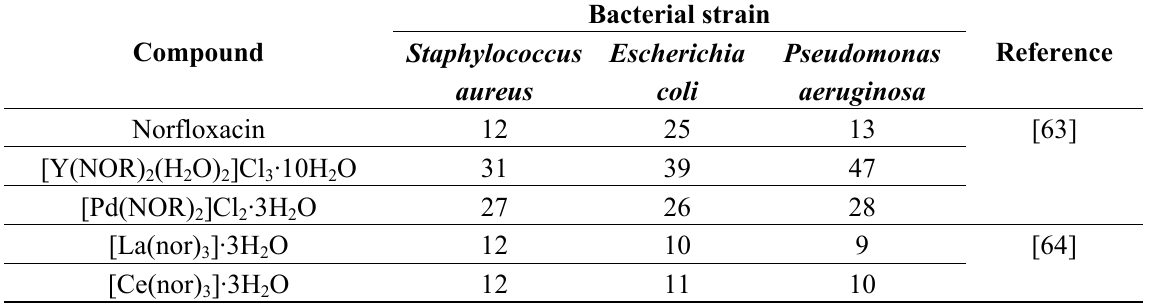
Table 8. The inhibition diameter zone values (mm) for norfloxacin and some of its